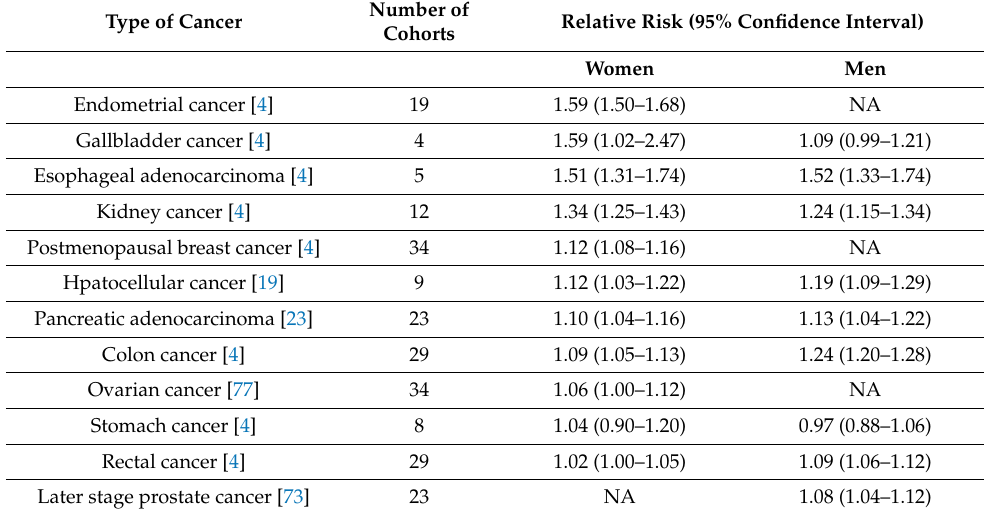
Table 2. Gender-specific summary of cancer risk for each 5 kg per m 2 increase in BMI for major cancers with strong evidence of relationship with